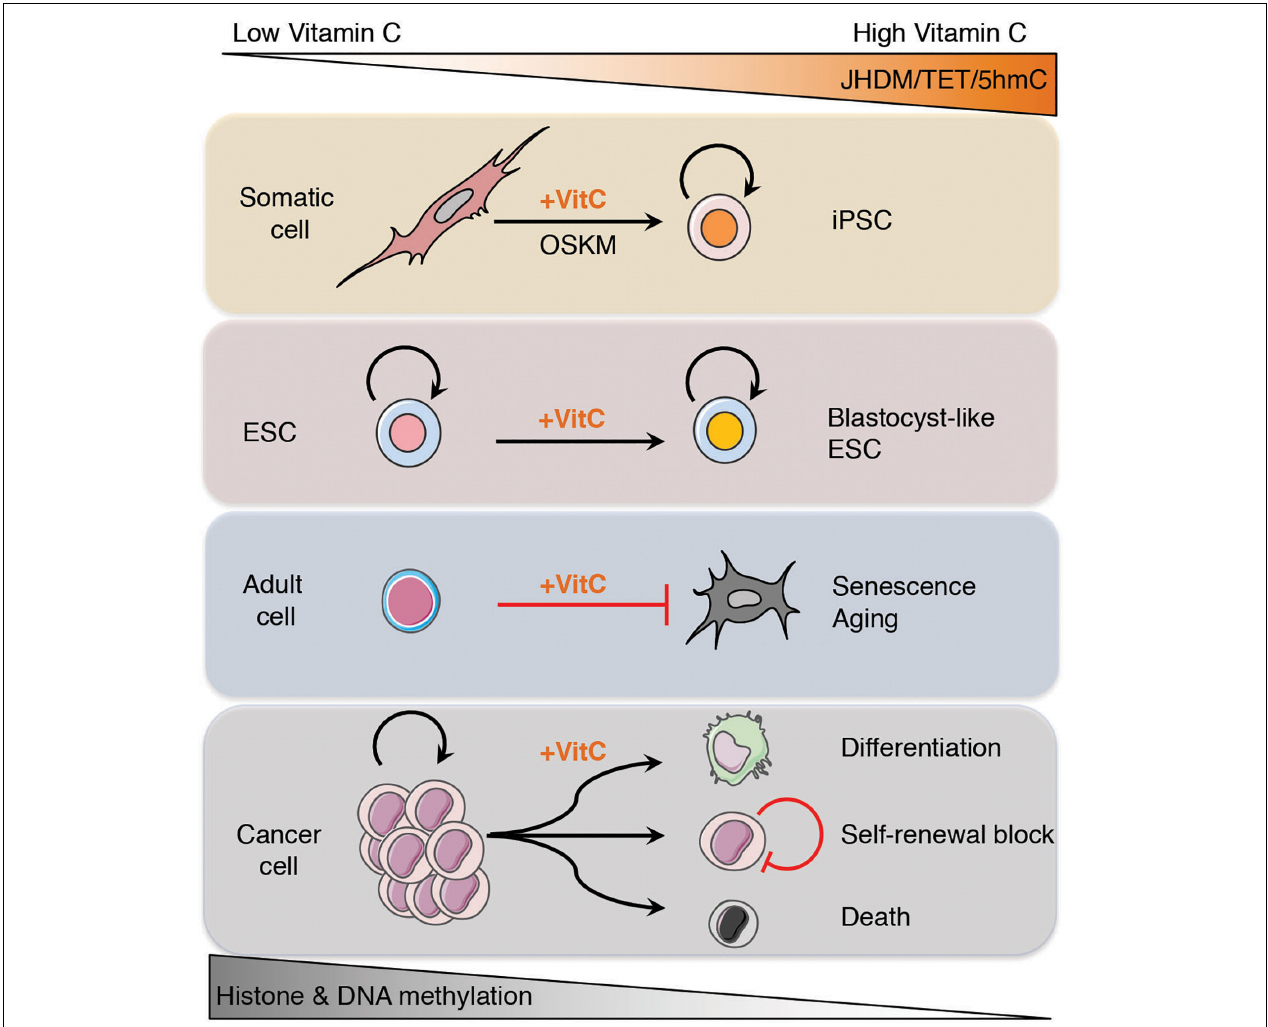
FIGURE 3 | Vitamin C reprograms the epigenome to reverse commitment, prevent senescence and restore differentiation potential. Under growth conditions with low levels of vitamin C, the epigenome of cells becomes hypermethylated, most likely due to suppressed activity of α -ketoglutarate dependent dioxygenases ( α -KGDDs) including Jumonji-C domain-containing histone demethylases (JHDMs) and ten-eleven translocation (TET) proteins. By increasing the levels of vitamin C, JHDM, and TET enzymatic activity is enhanced, leading to the loss of histone and DNA methylation, respectively, that promotes somatic cell reprograming, increased differential potential of ESCs toward a blastocyst-like state, protects adult cells from senescence and aging, and can drive the differentiation or death of cancer cells.